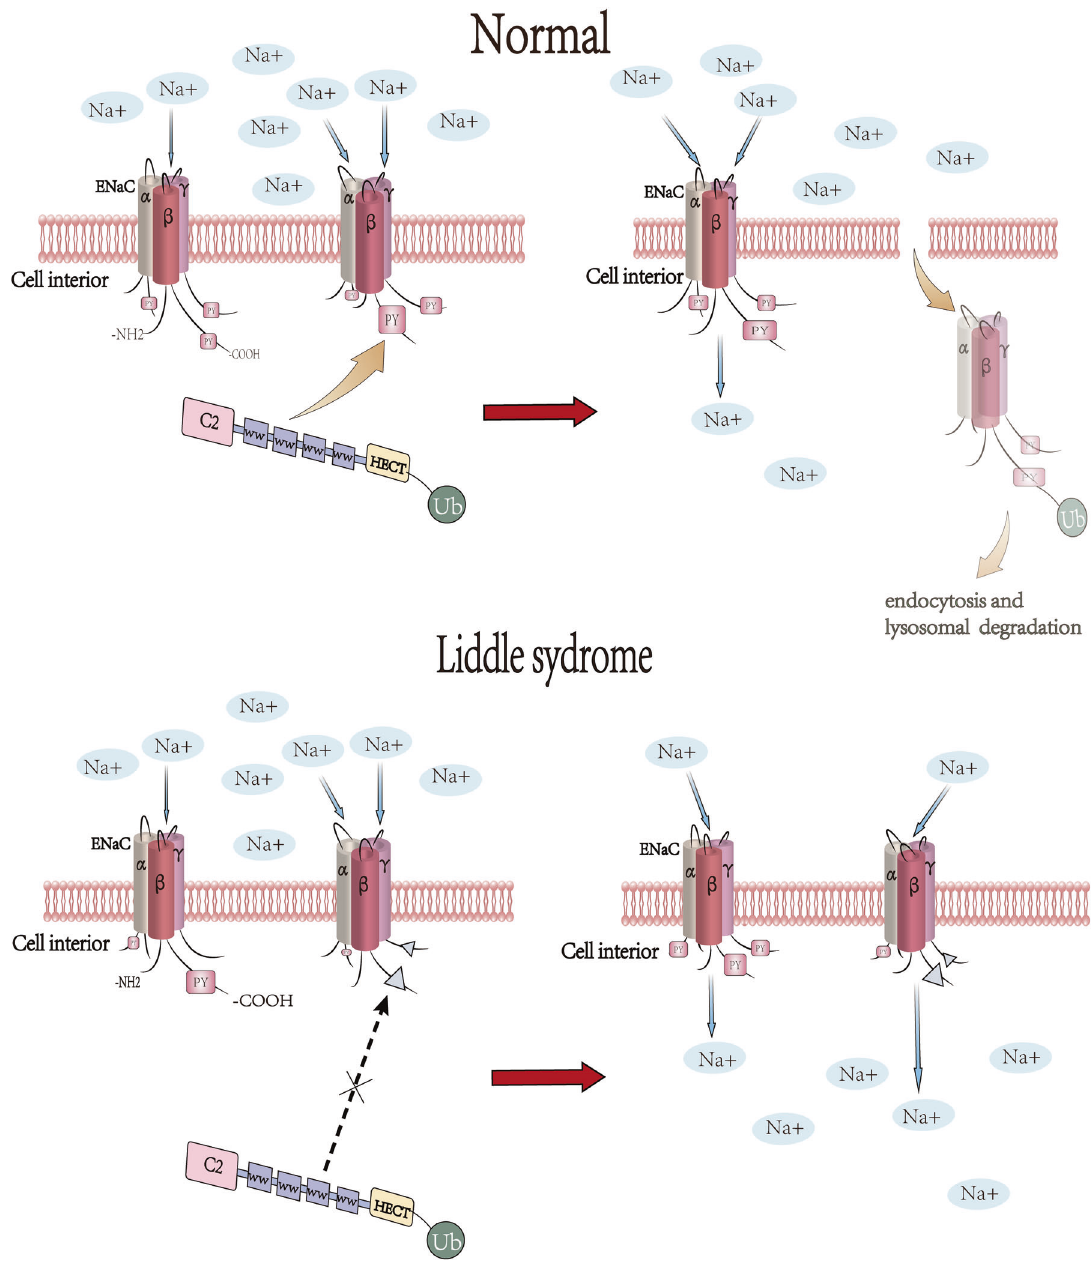
Fig. 2 The molecular mechanism of the differences between the normal and liddle syndrome. Neuronal precursor cell expression developmentally downregulated 4-like(Nedd4L) is composed of C2 domain, four WW domains and HECT domain. α , β , and γ subunits of ENaC contains a conserved proline-tyrosine (PY) motif at the C-terminus which is also the binding site for the ubiquitin ligase Nedd4L. After mutation in this PY motif happens, the binding capacity to the WW domain of Nedd4L will decrease; thereby accelerate the cell activity and expression of ENaC, leading to its uncapable of degradation. Ultimately, increase the absorption of sodium ion in the distal